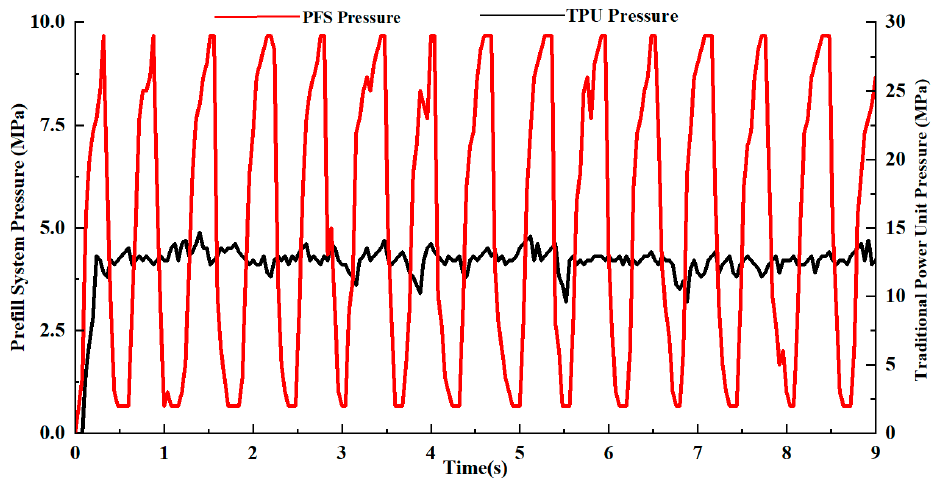
Figure 6. Output pressure of the prefill system and the main power unit during fast forging.